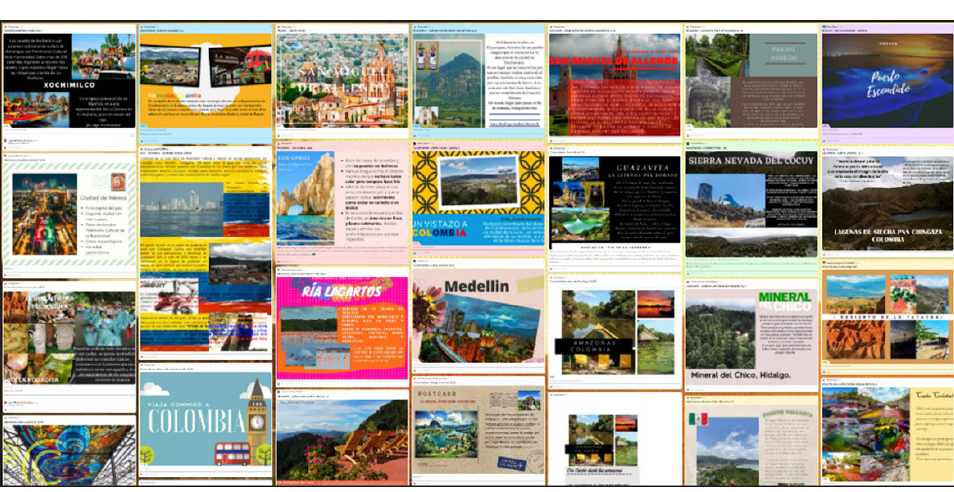
Fig. 3. Images of the icebreaker activity of the Nepenthes challenge